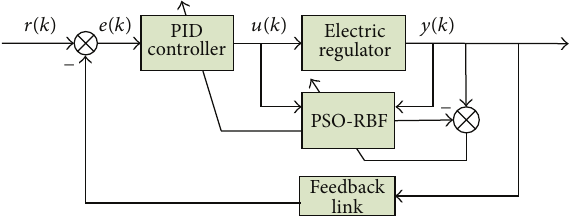
Figure 3: The PID control block diagram set by PSO-RBF